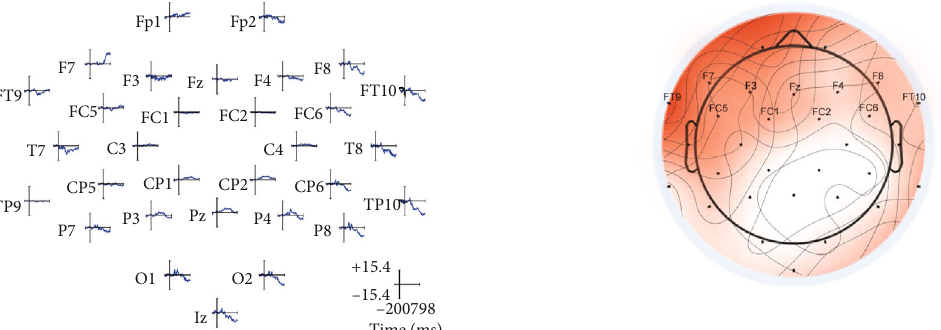
Figure 5: Electrode and topographic (3) The expected value of 20 people ’ s EEG data is